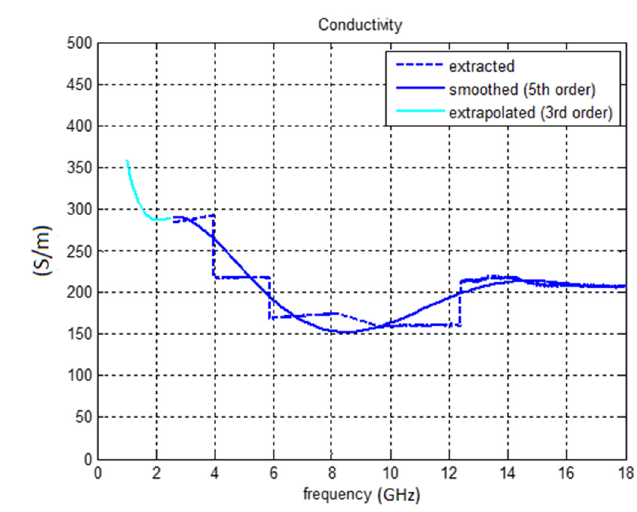
Figure 8. Measured effective conductivity of the polymer composite comprising carbon nanotubes and polymer matrix (measurement on the flange of the rectangular waveguide).